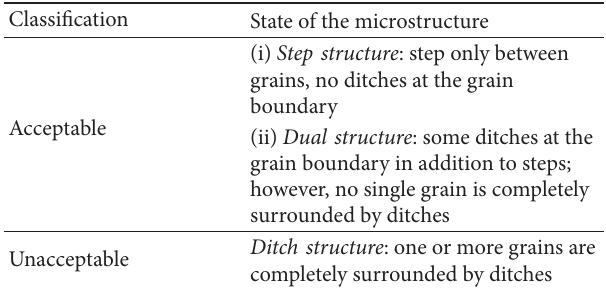
Table 3: Classification of etched structure in oxalic acid electrolytic etch